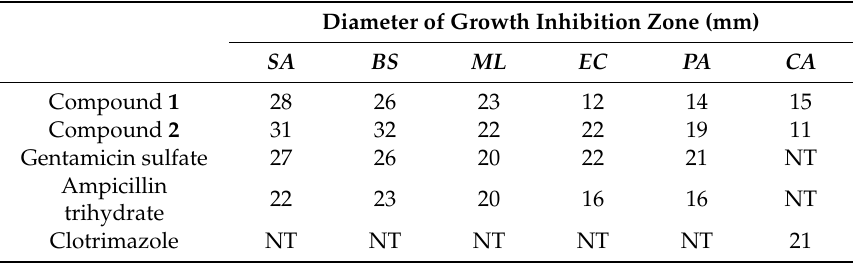
Table 3. In vitro diameter of growth inhibition zones of compounds 1 , 2 (200 µ g / 8 mm disc), the broad-spectrum antibacterial drugs Gentamicin sulfate and Ampicillin trihydrate, and the antifungal ATCC 5256 ( BS ), Micrococcus luteus ATCC 27141 ( ML ), Escherichia coli ATCC 8726 ( EC ), Pseudomonas aeruginosa ATCC 27853 ( PA ), and the yeast-like pathogenic fungus Candida albicans MTCC 227 ( CA